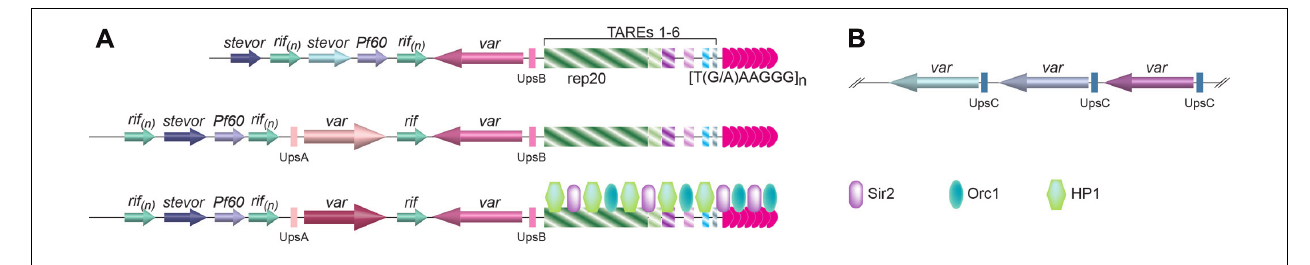
located at subtelomeric regions and transcribed in opposite directions as drawn, while the ones with associated UpsC are located as gene arrays in chromosome-internal loci (B) . Little is known about the telomere proteins in Plasmodium , except that Sir2 and Orc1 is located at the telomere vicinity (Mancio-Silva etal., 2008), and HP1 is associated with subtelomeric TAREs (Perez-Toledo etal., 2009), which are shown in the bottom diagram in (A)